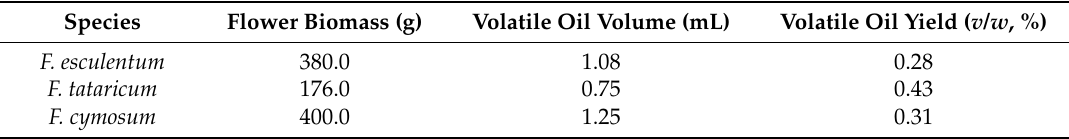
Table 1. The volatile oil yield of F. esculentum , F. tataricum and F. cymosum flowers.